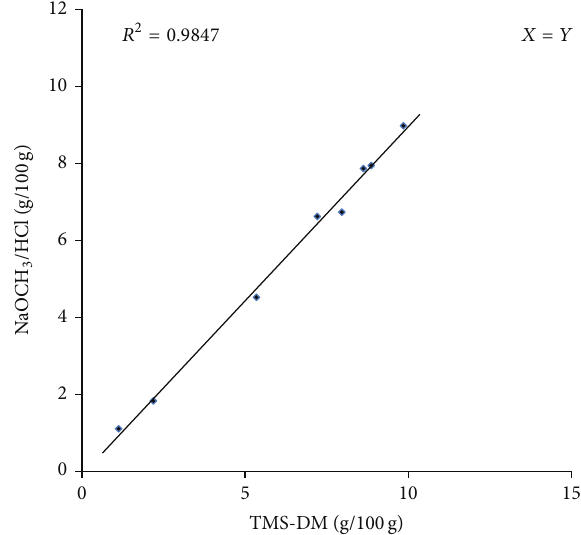
Figure 3: Comparison of C18:1 cis -9 measurements (g/100g) by GC-FID based on the KOCH 3 /HCl and TMS-DM derivatization procedures.